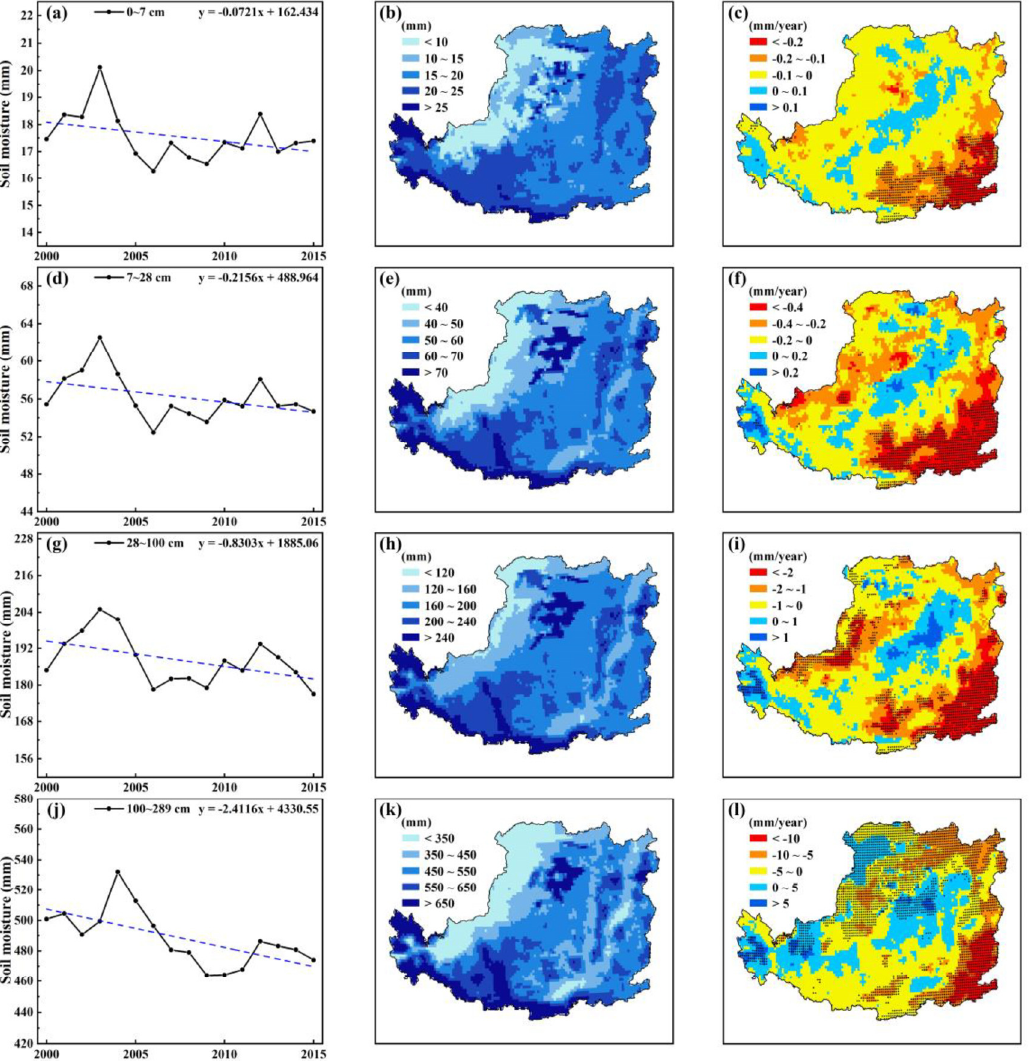
Figure 9. Spatiotemporal features of soil moisture on the LP during the period of 2000–2015. The left column shows the spatial pattern of linear trends (mm/year) in the 0–7-cm ( a ), 7–100-cm ( d ), 100–289-cm ( g ) and 0–289-cm ( j ) soil layers. The middle column shows the annual mean soil moisture for the 0–7-cm ( b ), 7–100-cm ( e ), 100–289-cm ( h ) and 0–289-cm ( k ) soil layers, and the areas with a significant change ( p < 0.05) based on t -test are stippled. The right column shows the area-averaged annual soil moisture and its linear trends (mm/year) in the 0–7-cm ( c ), 7–100-cm ( f ), 100–289-cm ( i ) and 0–289-cm ( l ) soil layers.